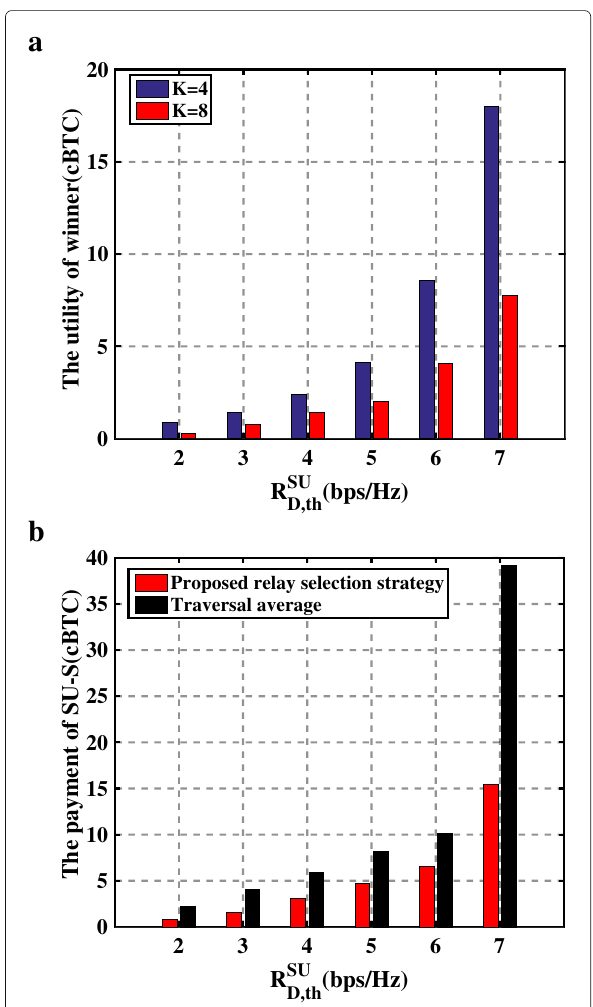
Fig. 12 Outage probability vs. the number of SUs and the energy levels. a The utility of winning relay vs. the expected. b The payment of SU-S vs. the expected